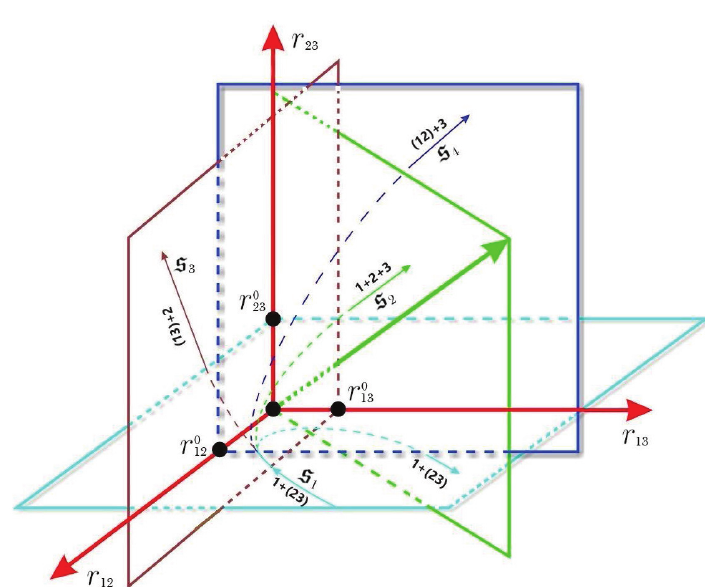
Figure 3. The set of smooth curves s = ( s 1 ,..., s 4 ) connecting ( in ) asymptotic subspace, where the three-body system is in a state 1 + ( 23 ) , with ( out ) asymptotic subspaces, where the following configurations of bodies are formed; 1 + ( 23 ) , 2 + ( 13 ) , 3 + ( 12 ) and 1 + 2 + 3, respectively. The r ij ( { ¯ ρ } ) ( i , j = 1,3, i (cid:54) = j ) denotes distance between i and j bodies, and r 0 between bodies in the corresponding pair. Note that all the curves s 1 , s 4 in the subspace ( in ) merges, which in the figure is shown by continuous